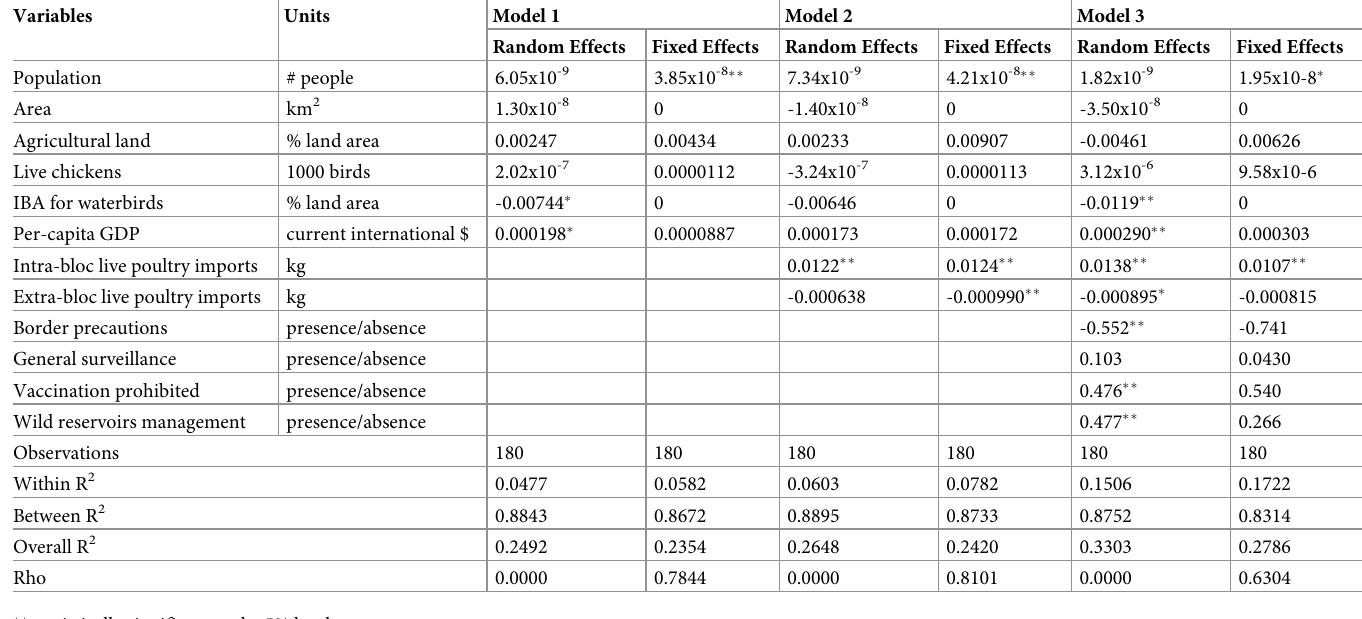
Table 4. Results from the regression models of H5N1 poultry outbreak risk factors for the Economic Community of West African States (ECOWAS); regressor coefficients are reported and statistically-significant factors are marked by asterisks. A blank space signifies that the variable was not included in the given